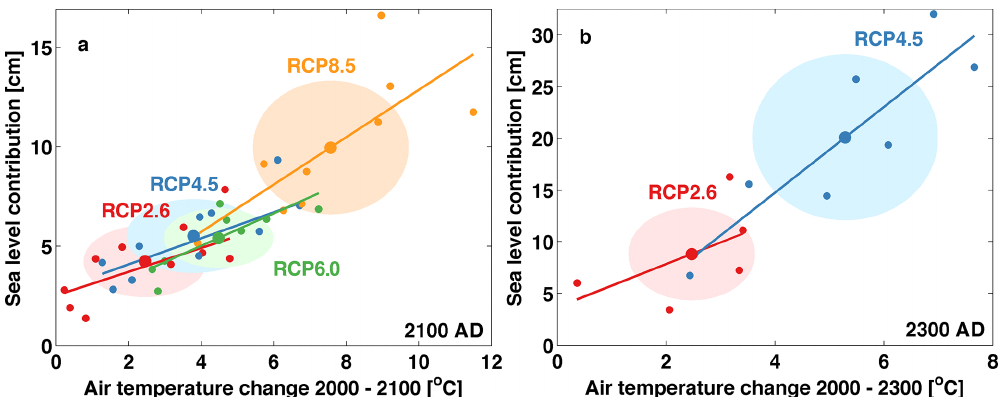
Figure B1. Greenland ice sheet contribution to global sea level change as a function of regional atmospheric warming by 2100 (a) and 2300 (b) . Temperature changes are taken as differences between 10 yr averages at either end of the projection period. Small dots represent each individual realisation with colours indicating the RCP scenario. The respectively coloured lines are a linear fit to each RCP response. Larger dots indicate the model averages for each RCP. Ellipses indicate rms deviations in both temperature change and sea-level